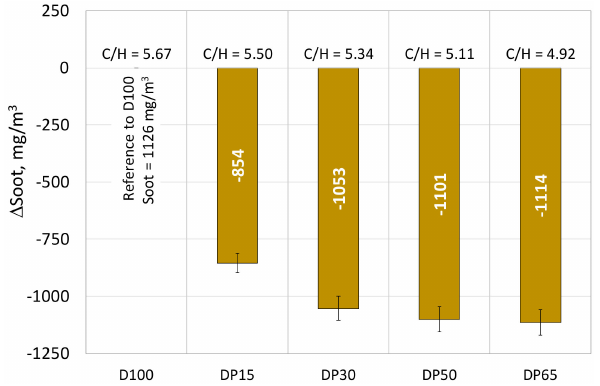
Figure 11. Soot emission for dual-fuel engine fueled by diesel and